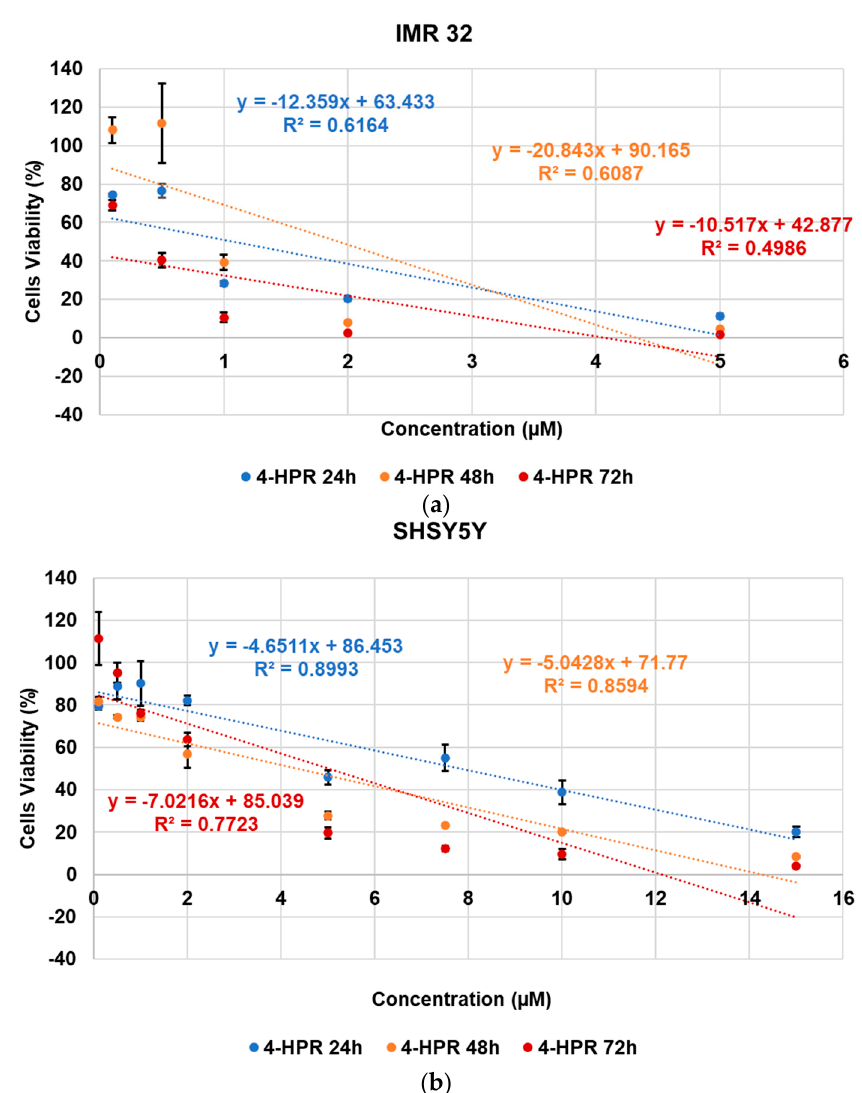
Figure 13. Dose-dependent cytotoxicity activity of 4-HPR at 24 h (blue), 48 h (orange), and 72 h (red) in IMR-32 cells ( a ) and SH-SY5Y cells ( b ) in the range 0.1–5 µM ( a ) and 0.1-15 µM ( b ).